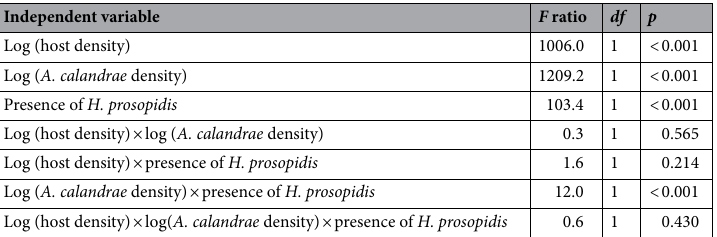
Log (host density) × log( A. calandrae density) × presence of H. Table 1. Effect tests for the general linear model of the reproduction of the native parasitoid Anisopteromalus calandrae (per female, per day; log-transformed) as a function of host density, A. calandrae density, the presence/absence of the nonnative parasitoid Heterospilus prosopidis , and all interactions.